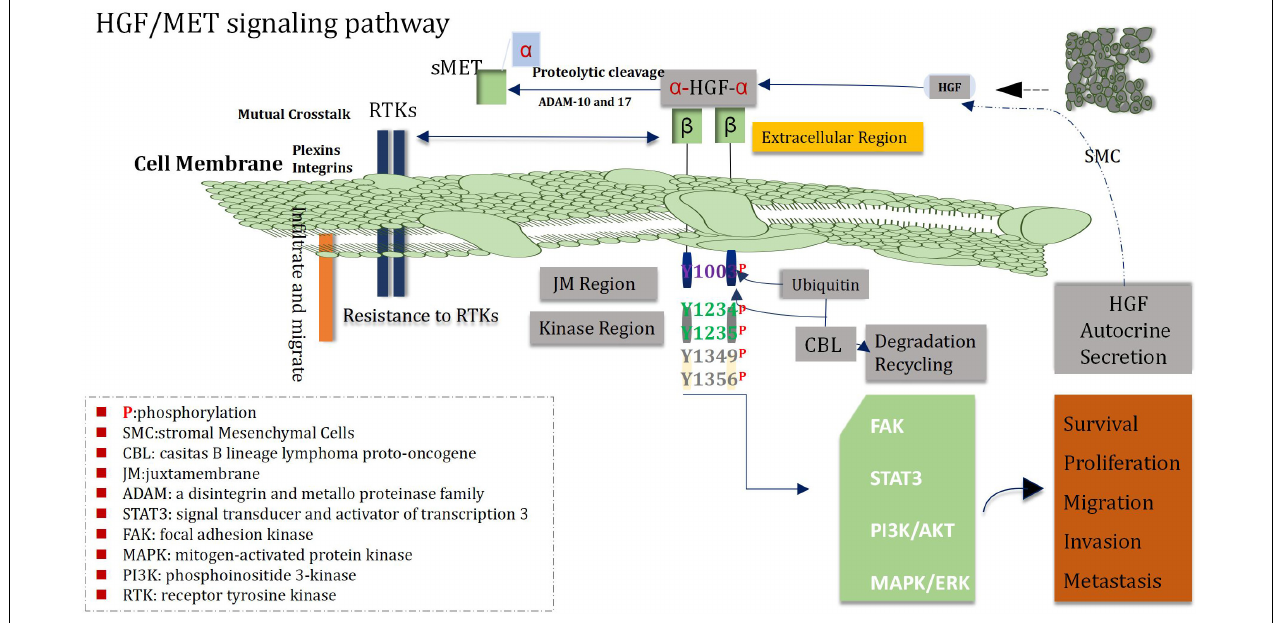
FIGURE 5 | HGF/MET signal